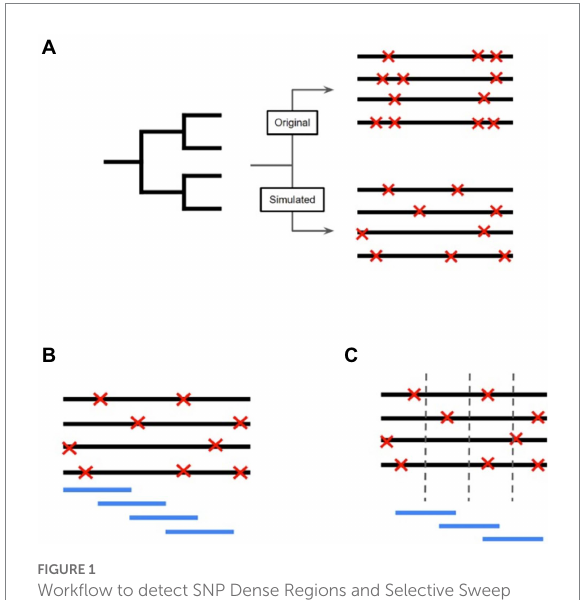
FIGURE 1 Workflow to detect SNP Dense Regions and Selective Sweep Regions in the Mycobacterium bovis genome. (A) The inferred phylogeny created using the original data is used as the input